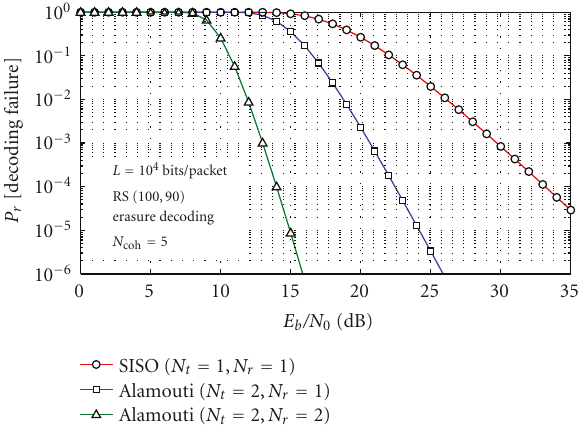
Figure 9: Probability of a decoding